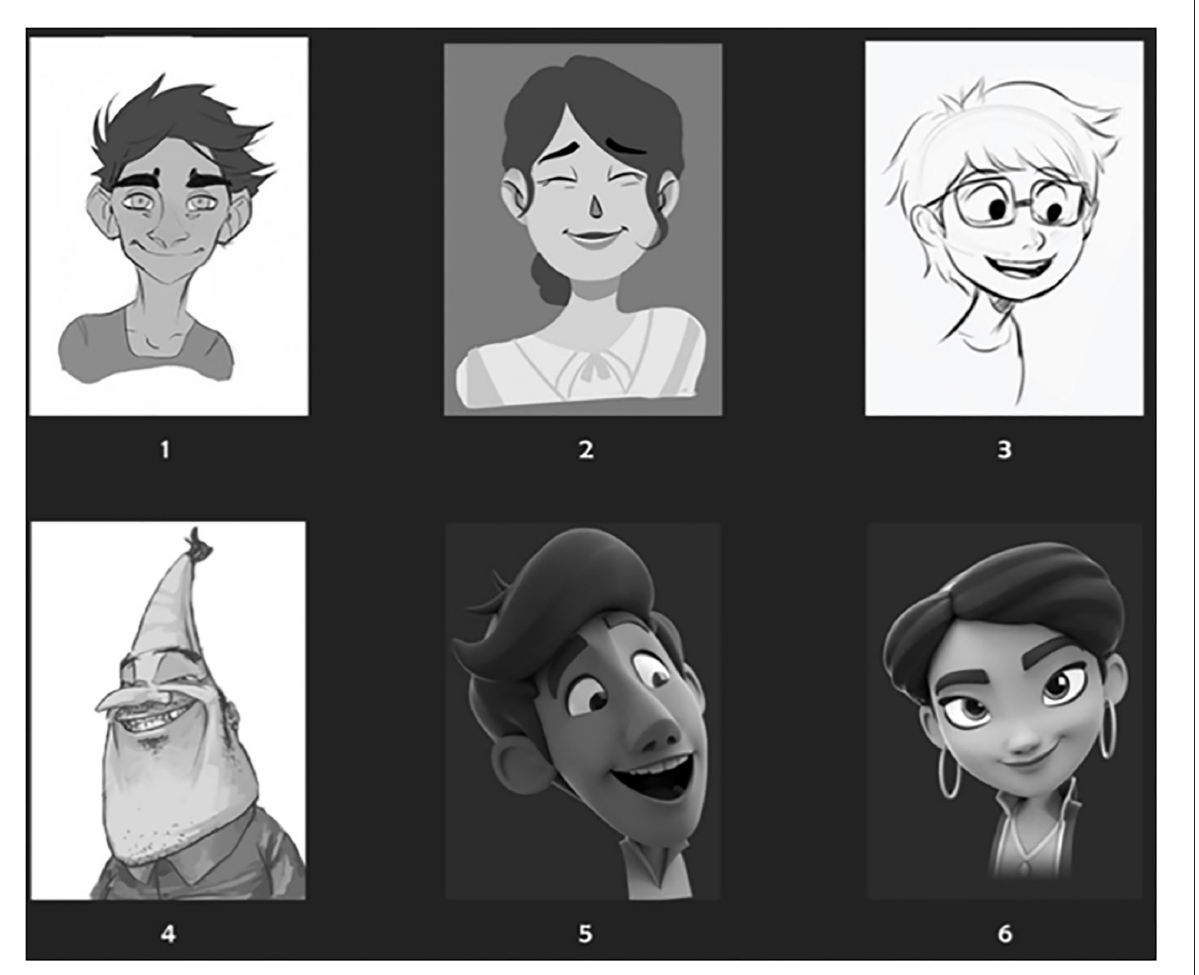
FIGURE2 2D and 3D character designs (see Table 1 for author references and character detail